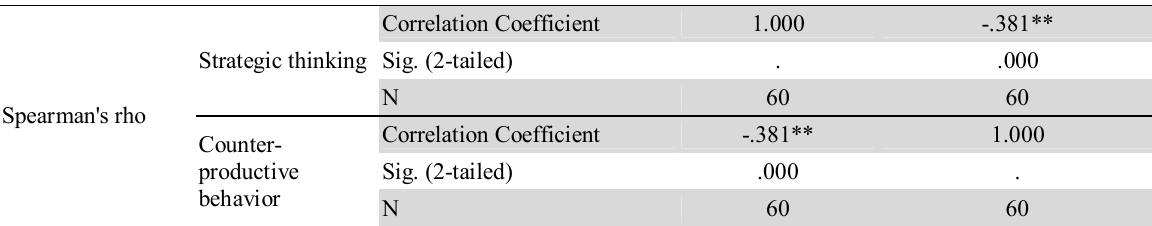
Correlation between strategic thinking and counterproductive behavior Strategic thinking Counter-productive behavior Correlation Strategic thinking Spearman's rho